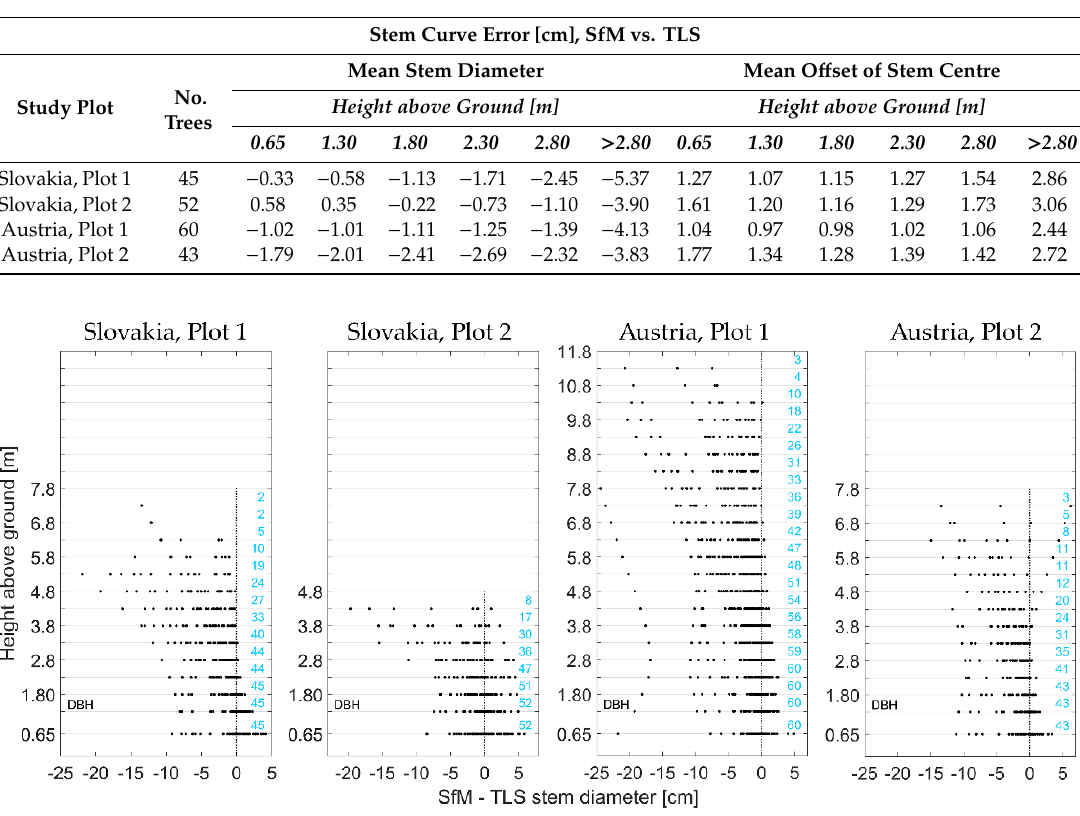
Table 6. Mean SfM stem curve error.